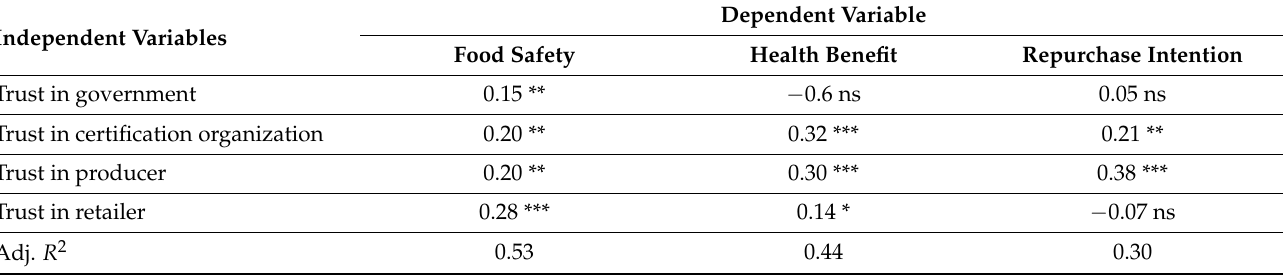
Table 3. Results of multiple regression